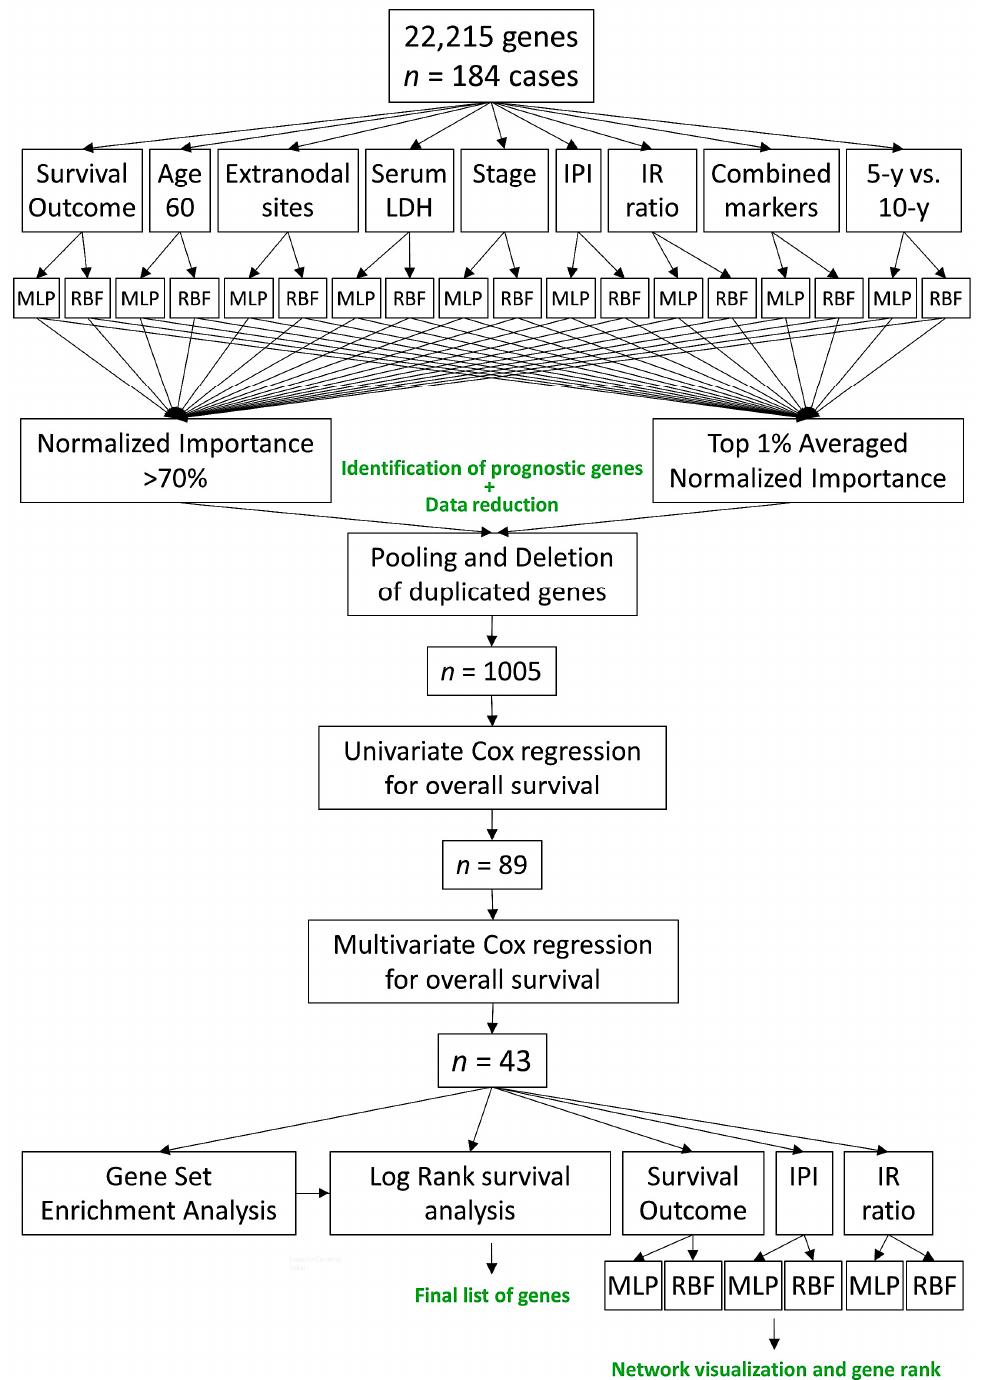
Figure 5. Artificial Intelligence analysis of follicular lymphoma. This figure shows the method used to analyze the gene expression data, which included a multistep process. From an initial set of 22,215 gene probes, a final set of 43 genes were identified, of which 18 were associated to a poor overall survival of the patients and 25 were associated to a good overall survival of the patients.